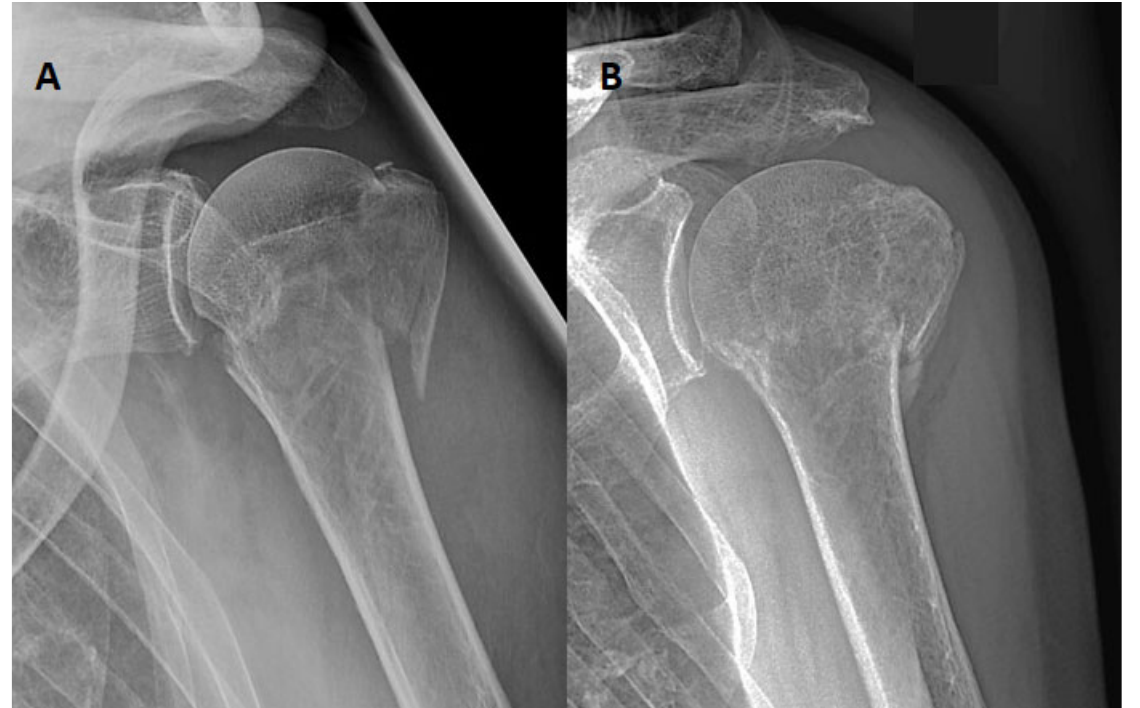
Figure 3. Case of a 72-year-old man of group [C] with an AO 11-B2 fracture, ( A ) anteroposterior X-ray from the fracture day. Patient-related termination of orthosis protocol after 96 h. ( B ) Anteroposterior X ‐ ray after 6 weeks with acceptable healing and CS above the average value of 70 points.